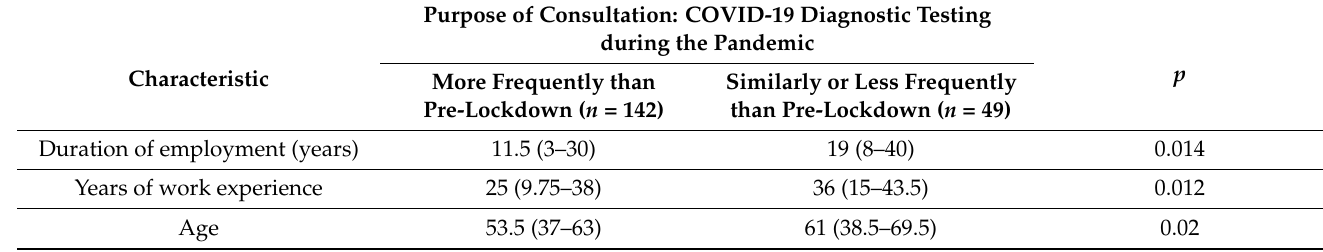
Table 4. The relationship between the sociodemographic characteristics of physicians and purpose of consultation being COVID-19 diagnostics.